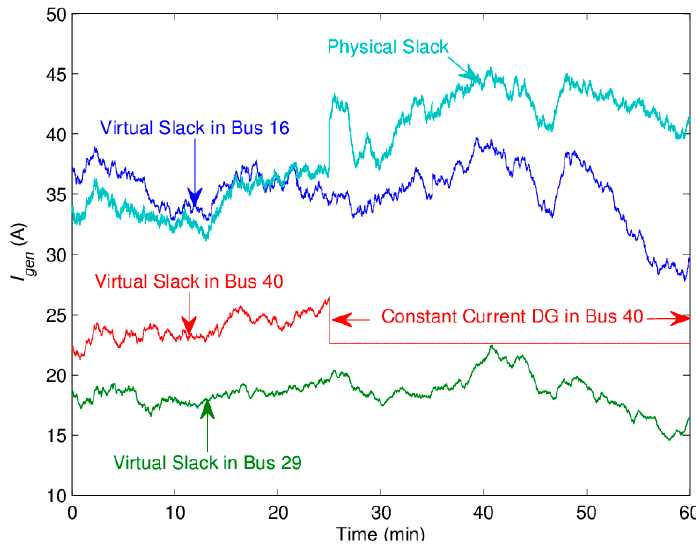
Figure 12. Currents after losing slack control in bus 40.